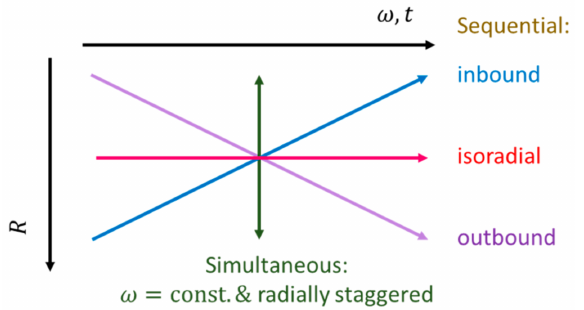
Figure 4. Representative scenarios underpinning multiplexing. The critical retention rates { Ω i , j } (11) of concurrently loaded (high-pass) valves { i , j } to be rotationally actuated at a time T i may be preserved while shifting the radial positions { R i , j } of the structures { Γ i , j } . This might be, for instance, required to meet spatial needs towards more crowded disc layouts, by adjusting the (permanently gas-filled part) of the compression chamber of volume V C,0, i , j , while observing proper arrangement in the frequency domain ω , e.g., to avoid overlapping bands by Ω i + M · ∆Ω i < Ω i + 1 − M · ∆Ω i + 1